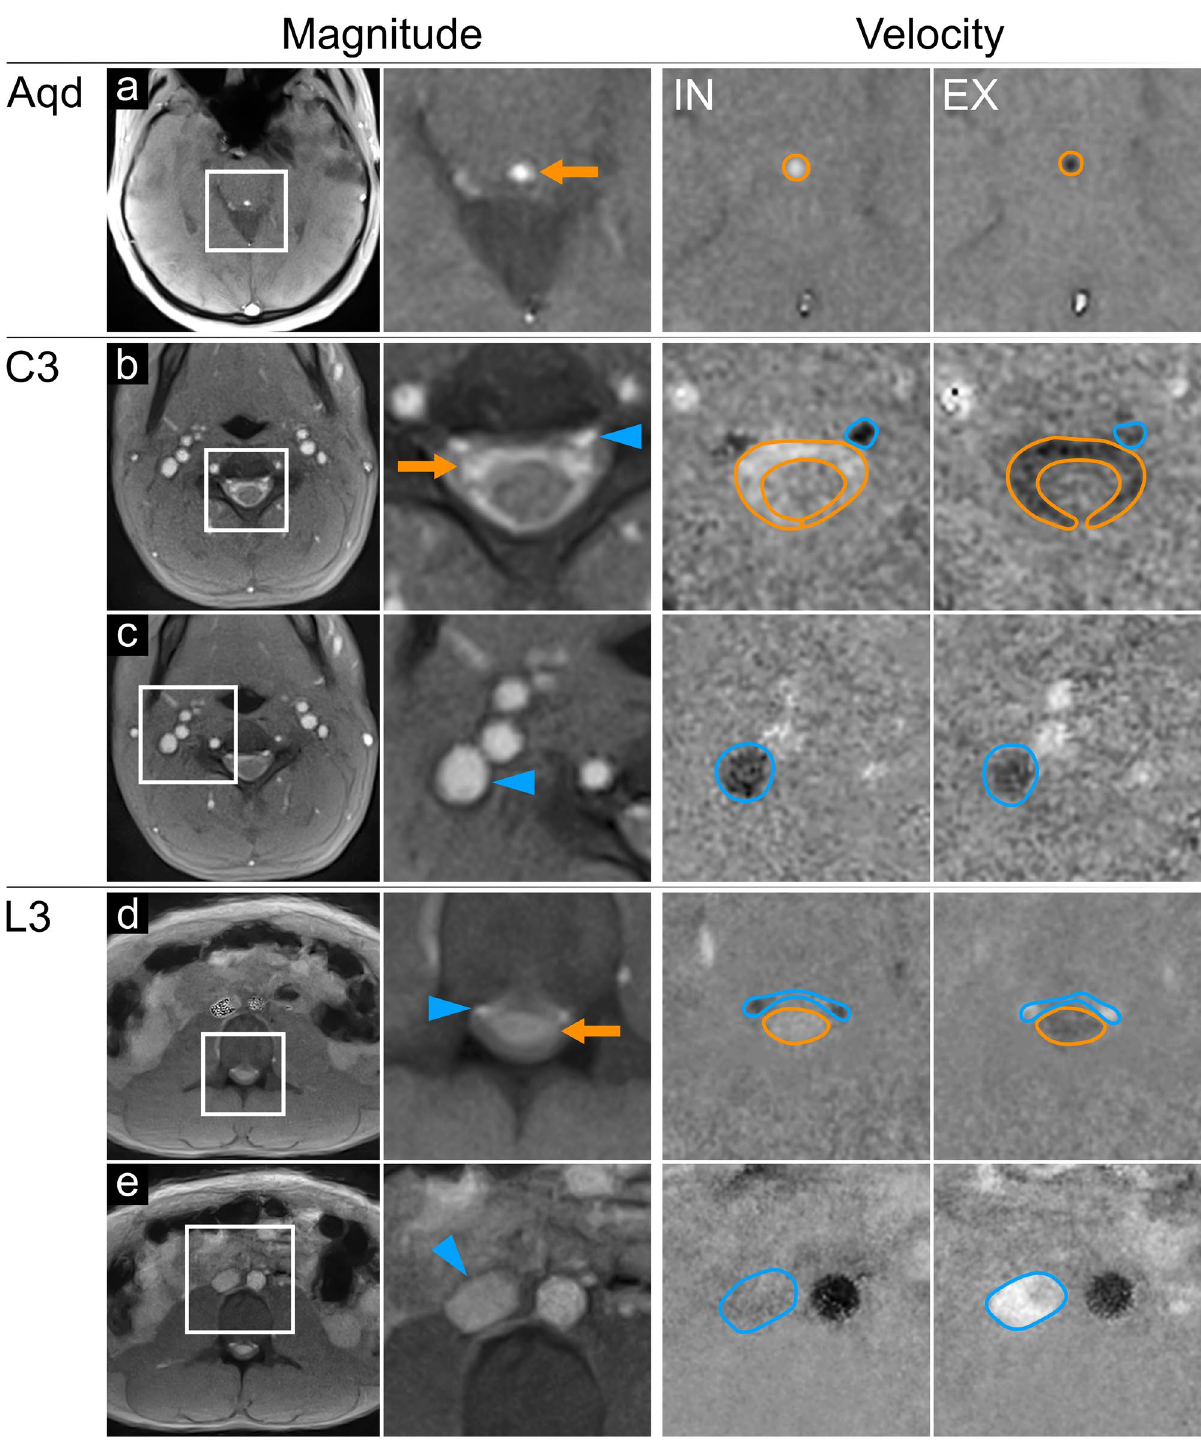
Figure 1. Regions of interest for CSF and venous flow analyses. Magnitude images (left columns) in normal and magnified views at the aqueduct. Aqd (( a ); subject #2), spinal cervical level C3 (( b,c ); subject #10), and lumbar level L3 (( d,e ); subject #5). CSF flow (orange arrows) appears as bright signal in the Aqd ( a ), the subarachnoid spaces at C3 ( b ) and L3 ( d ). Flow in cervical ( b ) and lumbar ( d ) EV (blue arrow heads) and in IJV ( c ) and IVC ( e ). Velocity maps (right columns) during forced inspiration IN and expiration EX . Magnified maps indicate upward CSF flow (bright signals in orange ROIs) at all levels ( a, b, d ) during IN. Spinal EV ( b,d ) and IJV ( c ) show simultaneous downward flow (dark signal in blue ROIs). Of note, flow in IVC (blue ROI, ( e ) subsides (grey signal). Downward CSF flow (dark signal) occurred at all levels ( a, b, d ) during EX. Flow in EV at C3 appears less dark ( b ), hence alleviated. Lumbar EVs ( d ) and IVC ( e ) show upward blood flow (bright). Aqd = aqueduct, C3 = cervical level 3, L3 = lumbar level 3, EV = epidural veins, IJV = internal jugular vein, IVC = inferior vena